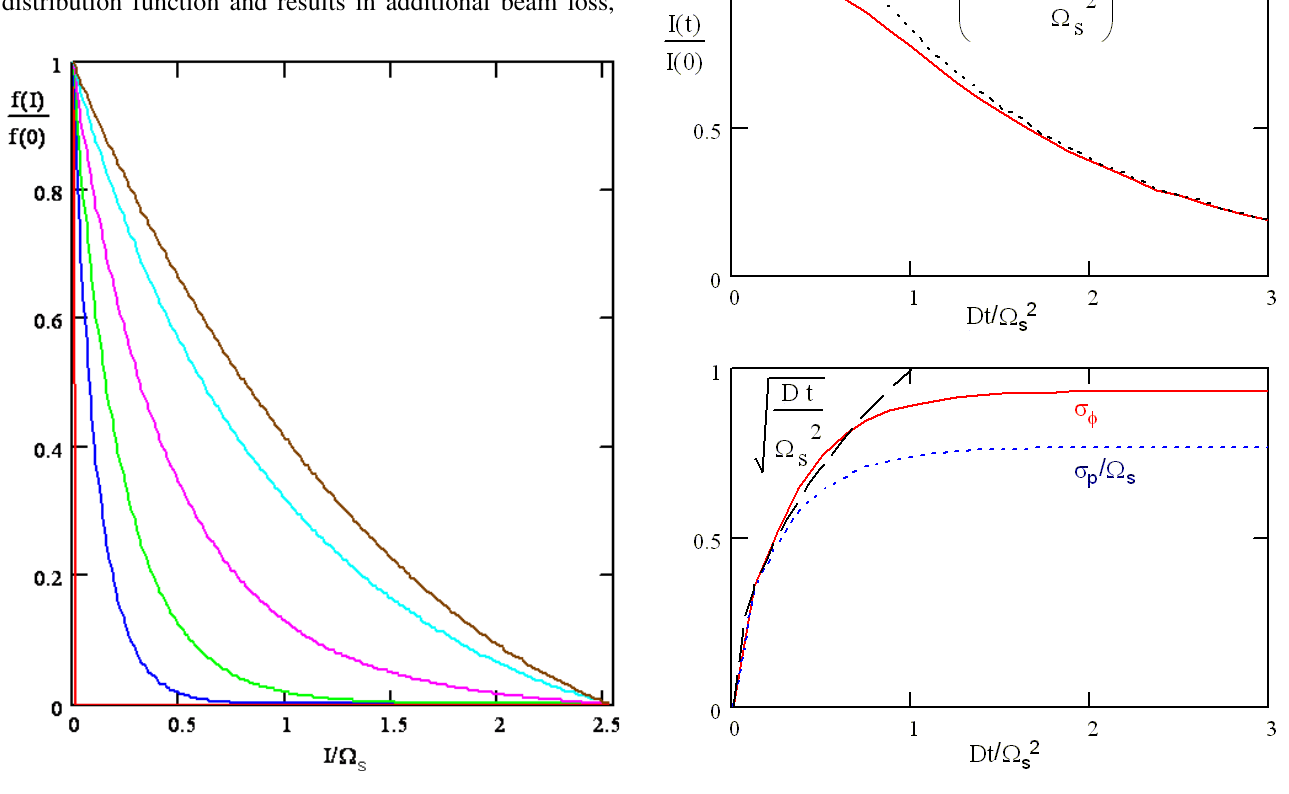
FIG. 2. (Color) Dependence of the distribution function on time 2 (cid:2) 0 , 0.125, 0.25, 0.5, 1 and asymptotic at t ! 1 . for Dt= (cid:2) s